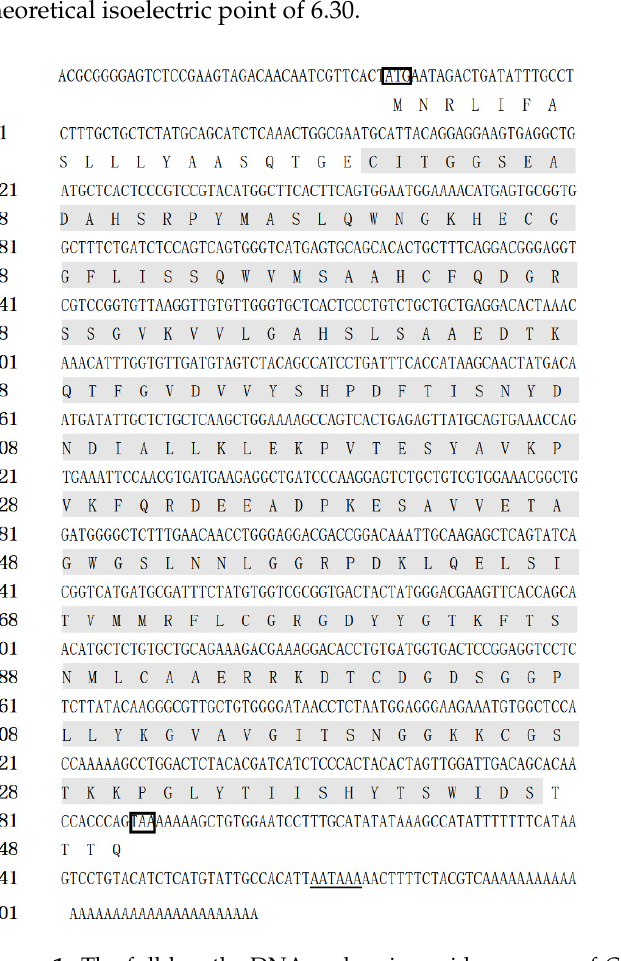
Figure 1. The full-length cDNA and amino acid sequence of Ci Df. The single Tryp_SPc domain (20–244 aa) is marked with a gray shadow, the initiation codon and stop codon are marked with a black box, and the “AATAAA” mRNA tail is underlined.